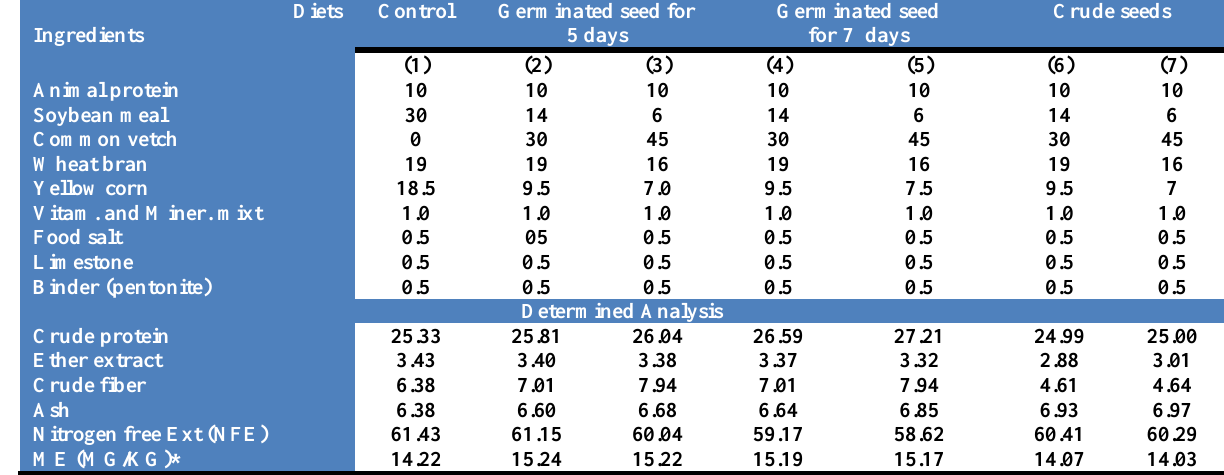
Table, 1: Dietary ingredient and proximate (% DM) of the experimental diets contains Vicia sativa seed treated with germination for 5 and 7 days.